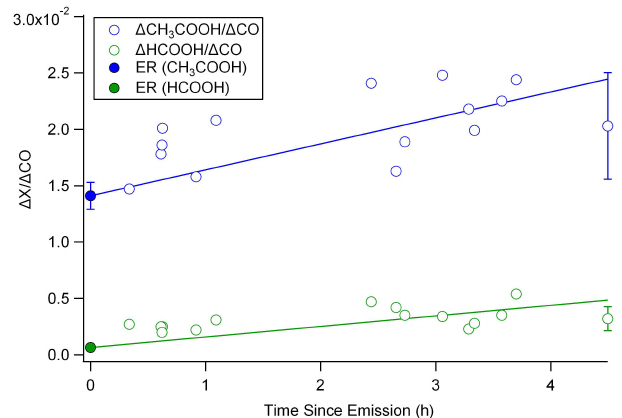
Fig. 6. Ln( 1 ethylene/ 1 CO) vs. time since emission (h) × ( k ethylene − k CO ) .